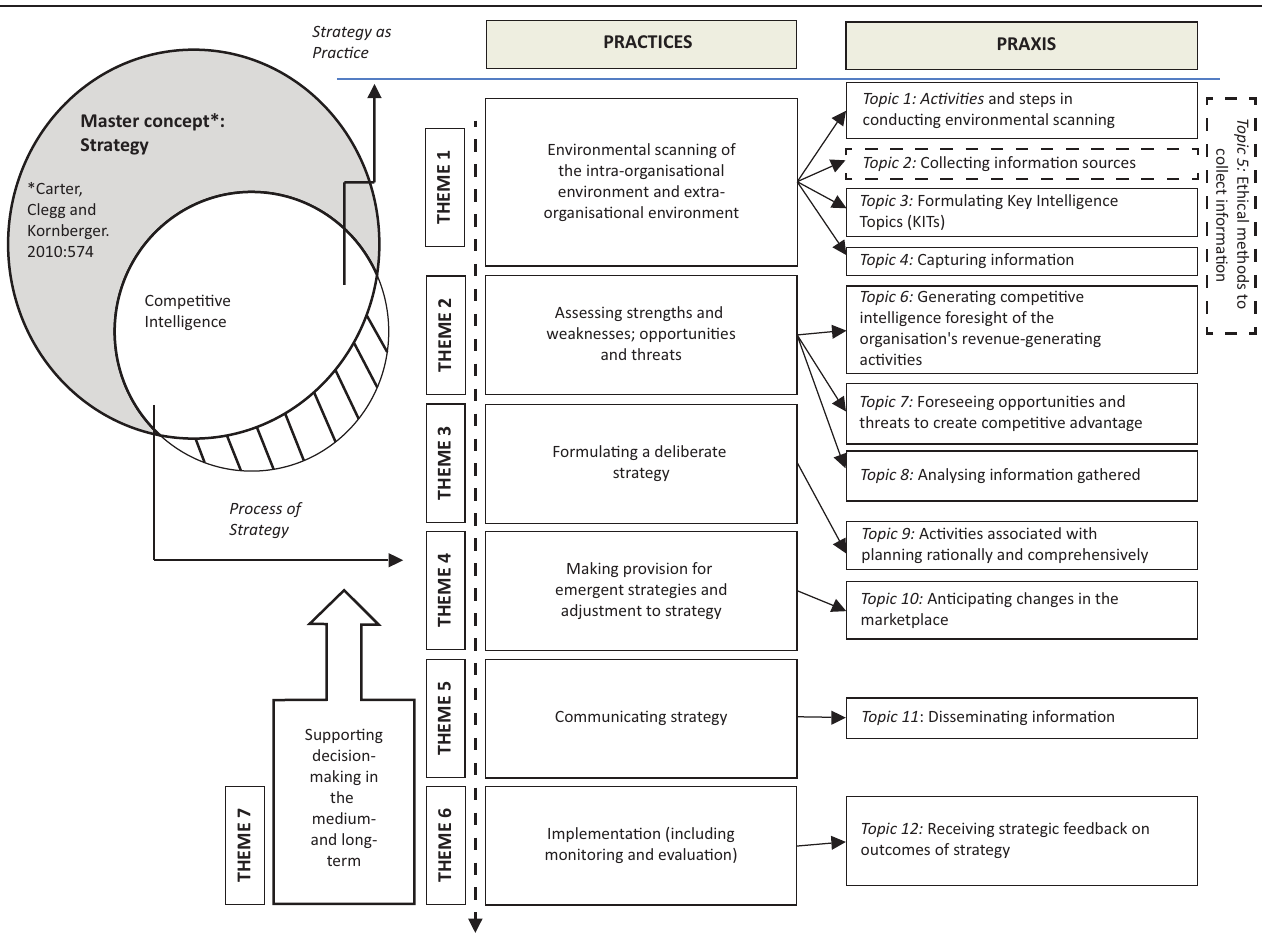
FIGURE 2: Integration of strategy and competitive intelligence: A conceptualised